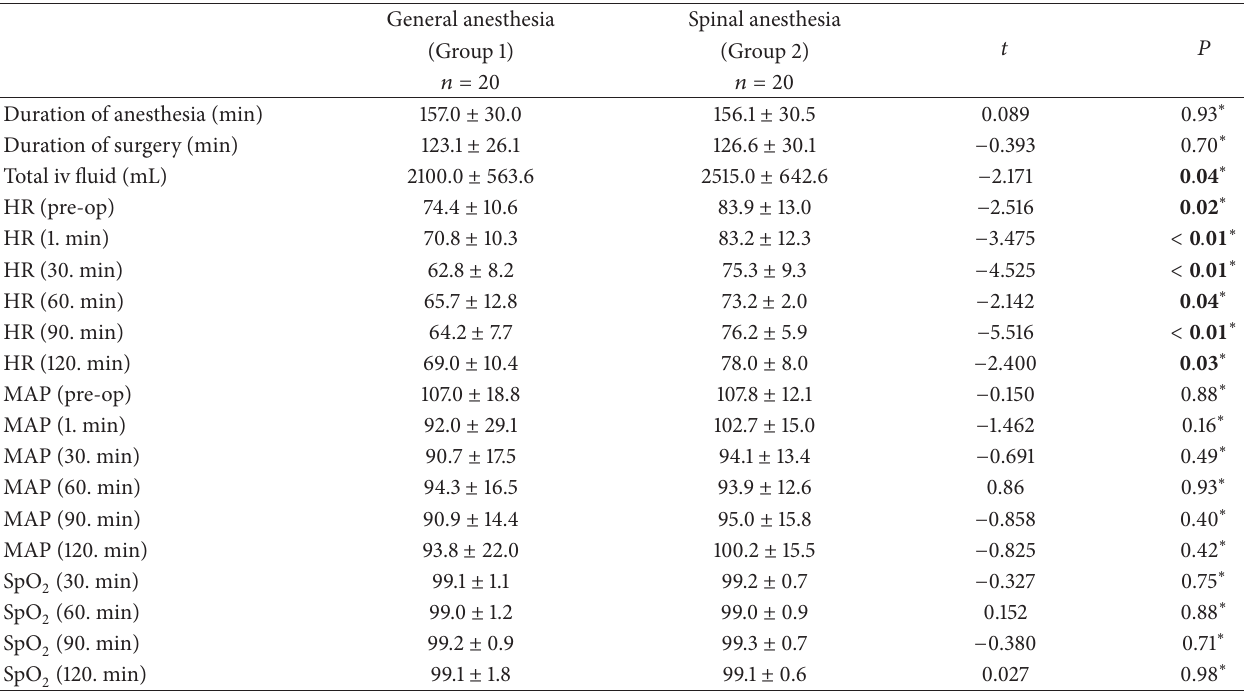
Table 2: Comparison of anesthetic parameters.